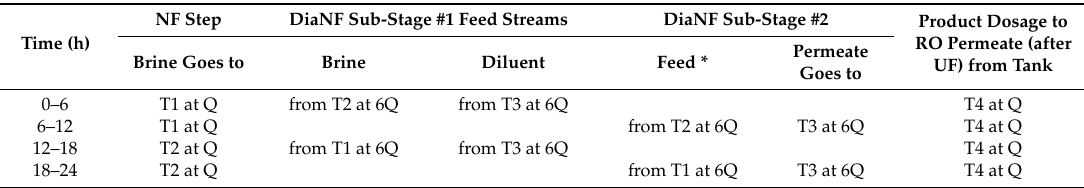
Figure 3. Schematic of the main plant components, the tanks used in each step, their sizes and the required flowrates. The first and second DiaNF sub-stages (3rd step of the proposed process) with intermittent diluent of DiaNF permeates and RO permeate, respectively, are shown in ( a , b ), respectively. ( c ) shows the dense-UF–NF process operated in parallel (1st and 2nd steps of the proposed process). Table 7. Process stages. Details of the tanks used in each step at each time.